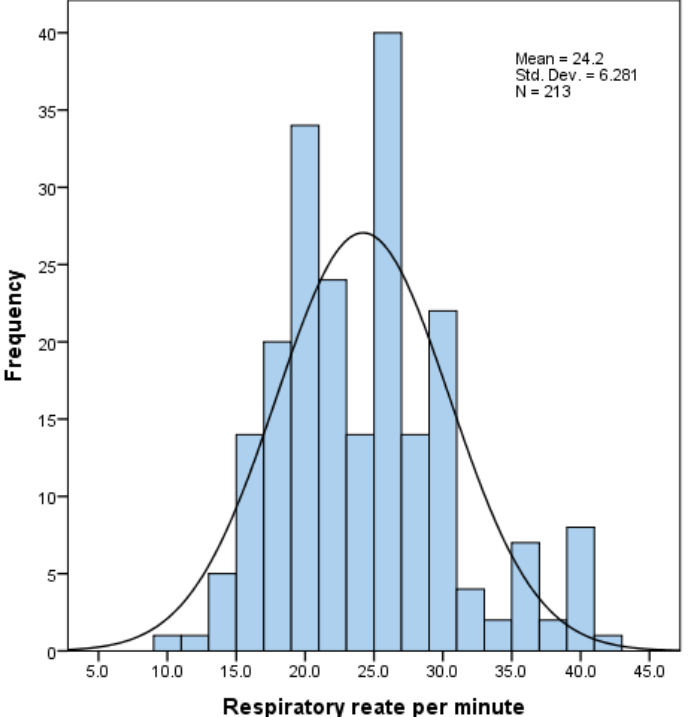
Figure 1. Respiratory rate distribution. The y-axis denotes the number of patients, x-axis denotes the respiratory